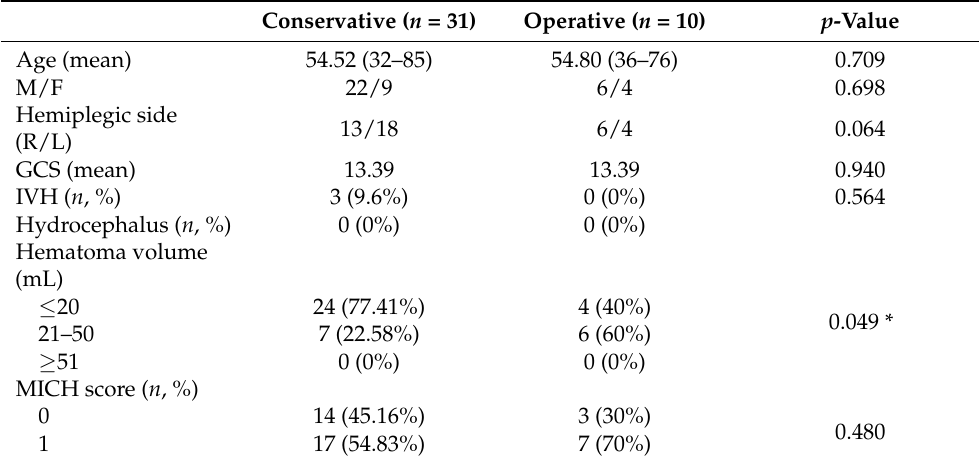
Table 2. Characteristics of patients.